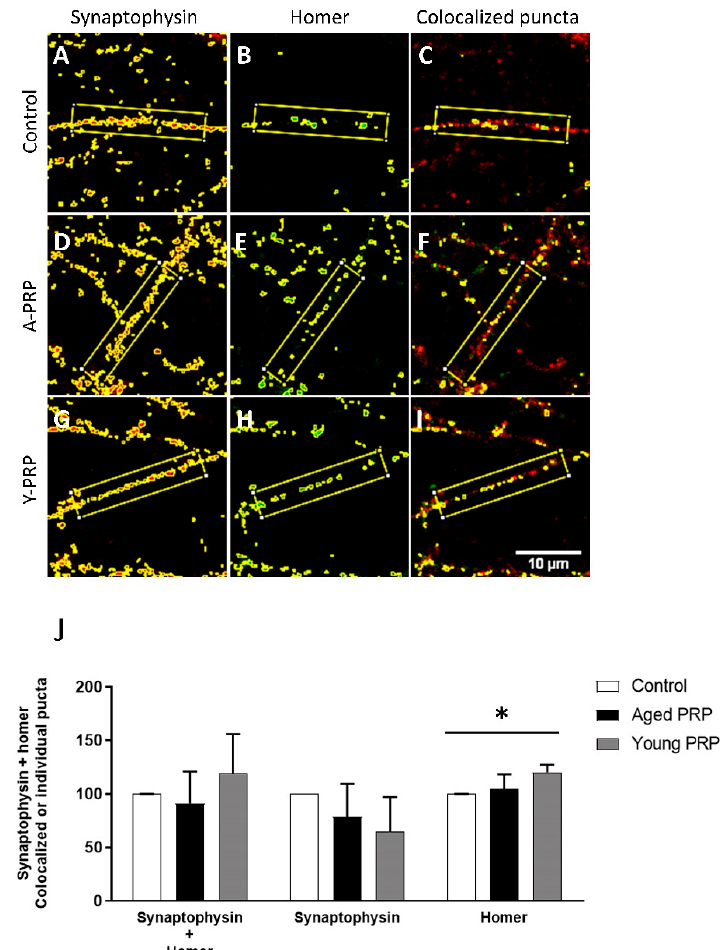
Figure 7. Young PRP increases Homer postsynaptic puncta. Representative images of individual Synaptophysin and Homer puncta and colocalized puncta in neuronal primary cultures treated with either Aged PRP or Young PRP ( A ‒ I ). Quantification of individual Synaptophysin and Homer puncta and the colocalized Synaptophysin and Homer puncta ( J ). A-PRP: Aged PRP; Y-PRP: Young PRP. * p < 0.05. Error bars = standard deviation.